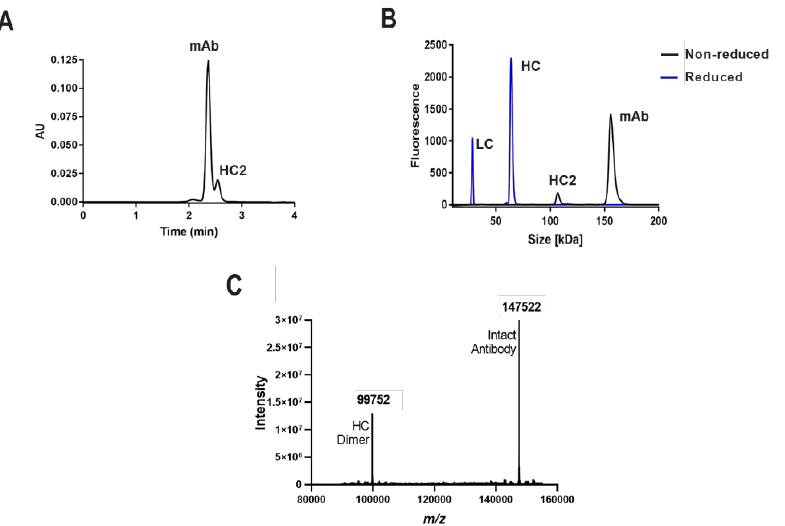
Figure 1. Detection of HC2 species in humanized mAb-A molecule by ( A ) SE-UPLC and ( B ) NR- and Red-cSDS (profiles overlaid). ( C ) Confirmation of HC2-A species by intact mass spectrometry from a mixture of mAb and HC2 species.